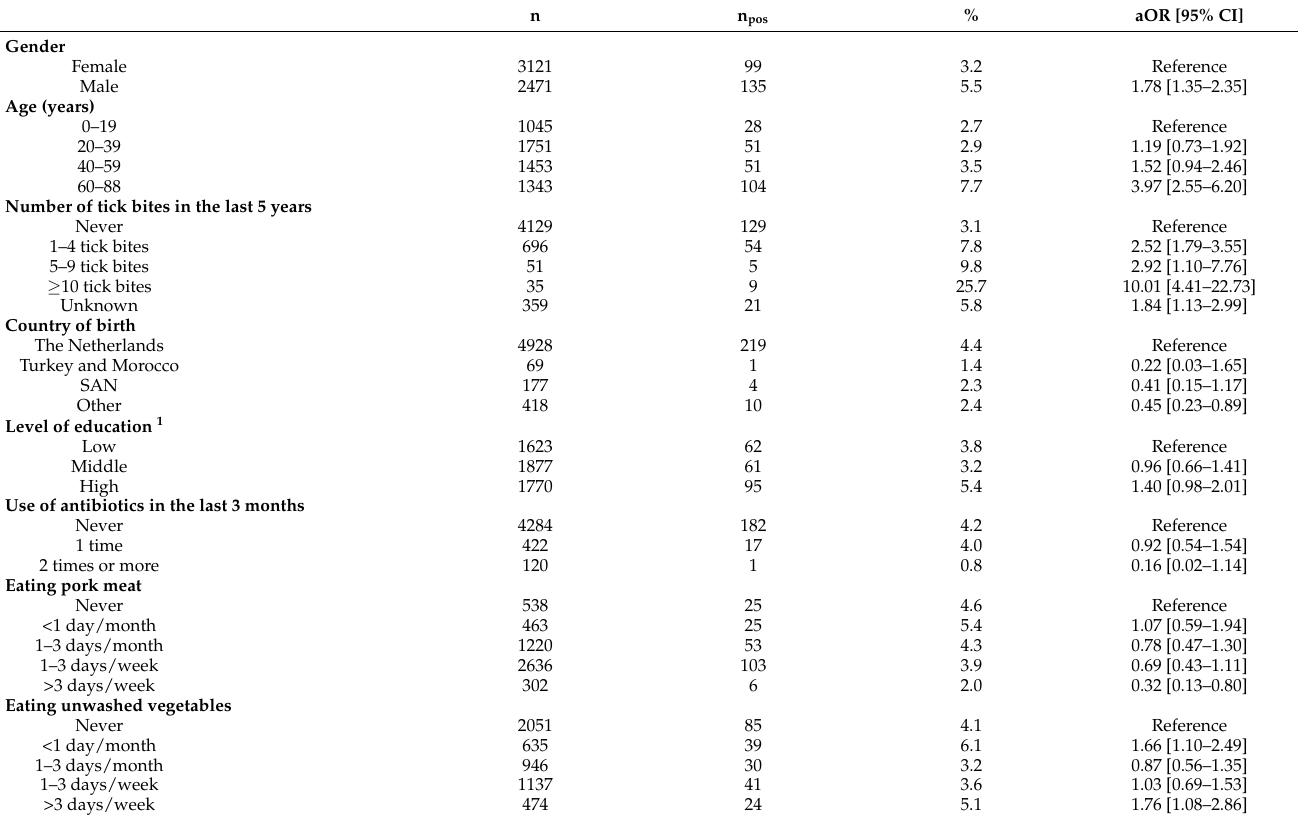
Table 2. Risk determinants for